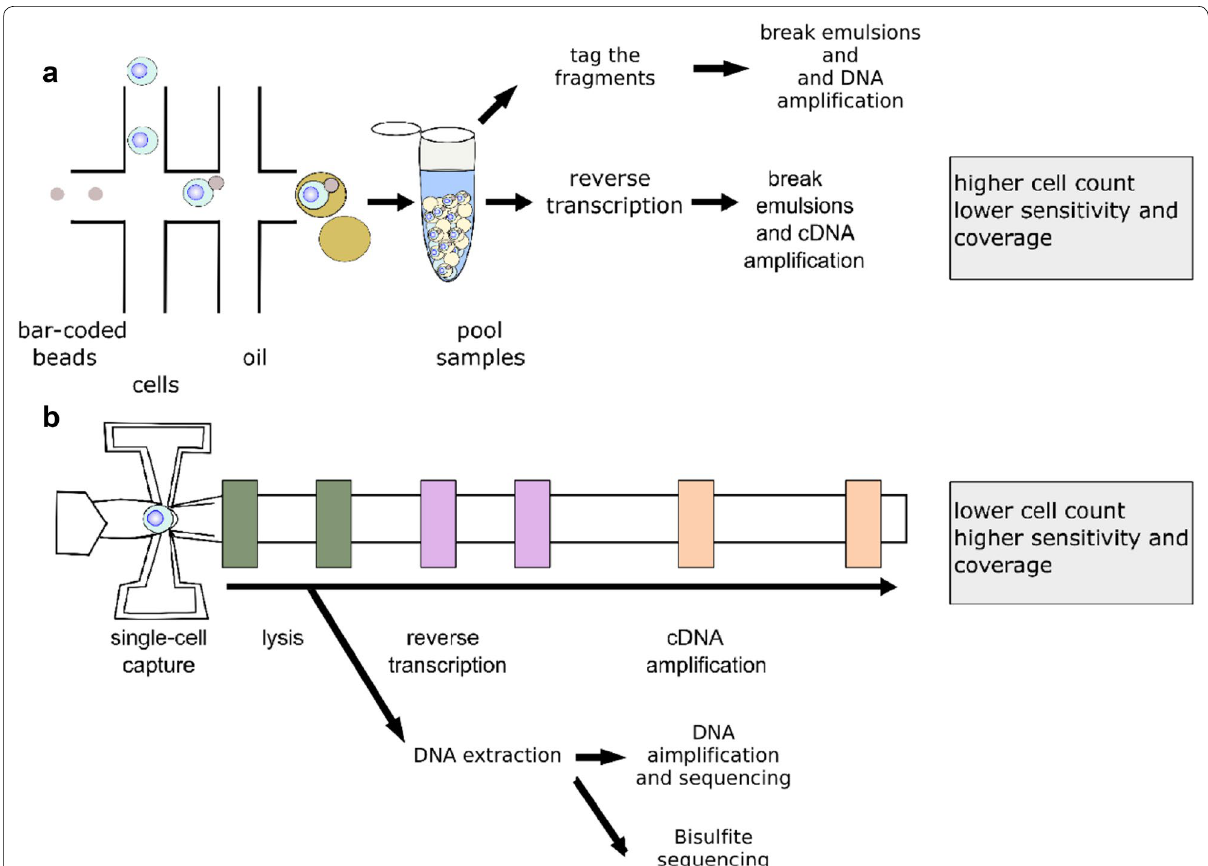
Fig. 3 Single-cell isolation and preparation. a One method for isolating single-cells is by droplet microfluidics. In the first channel, individual cells are coupled with uniquely bar-coded beads that continue down the pipe until they are captured by an oil droplet. The oil droplets are then pooled in high quantities, and PCR is performed on the population. b A second approach for isolating single-cells is to pre-enrich cells by FACS then pass them through an IFC chip, which collects them into individual wells. IFC chips are available in different cell size ranges which assists in limiting the capture more than 1 cell/well. Unlike the droplet approach, PCR is performed on individual cells. This method results in lower overall cell counts than the droplet approach, however, there is a reported trade-off in sensitivity. Overall, droplet-based methods will yield higher numbers of cells per experiment, but the quality of data is more sparse, whereas, microfluidic chip methods provide a deeper cellular profile but with fewer cells. Researchers have to weigh the trade-off of single cell read depth or single-cell population